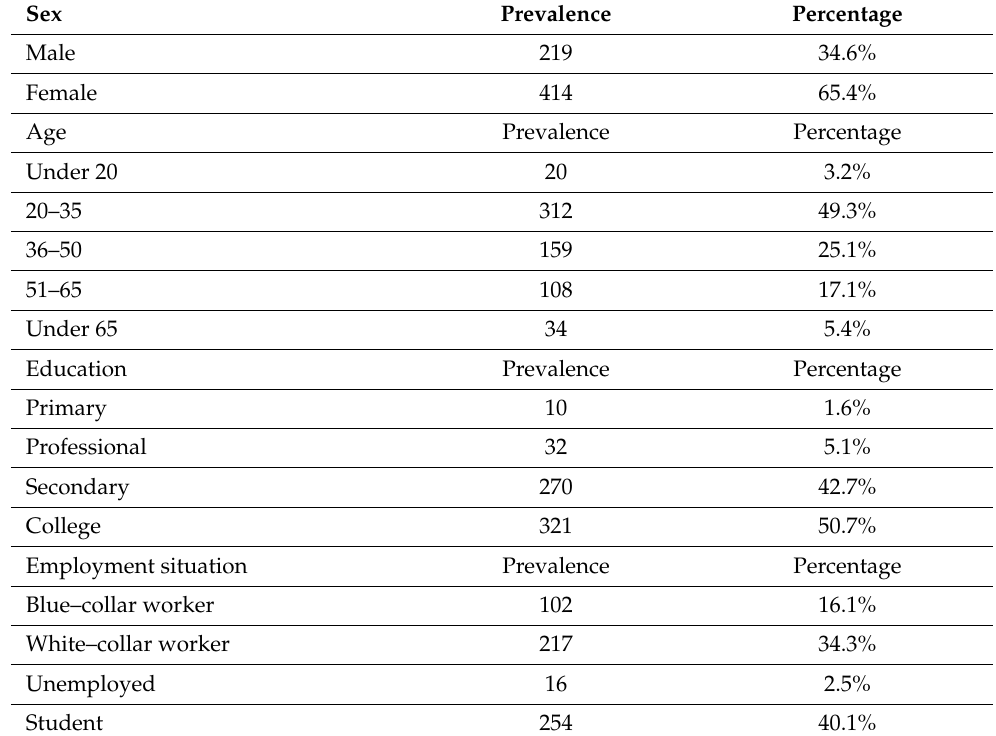
Table 1. Characteristics of the studied